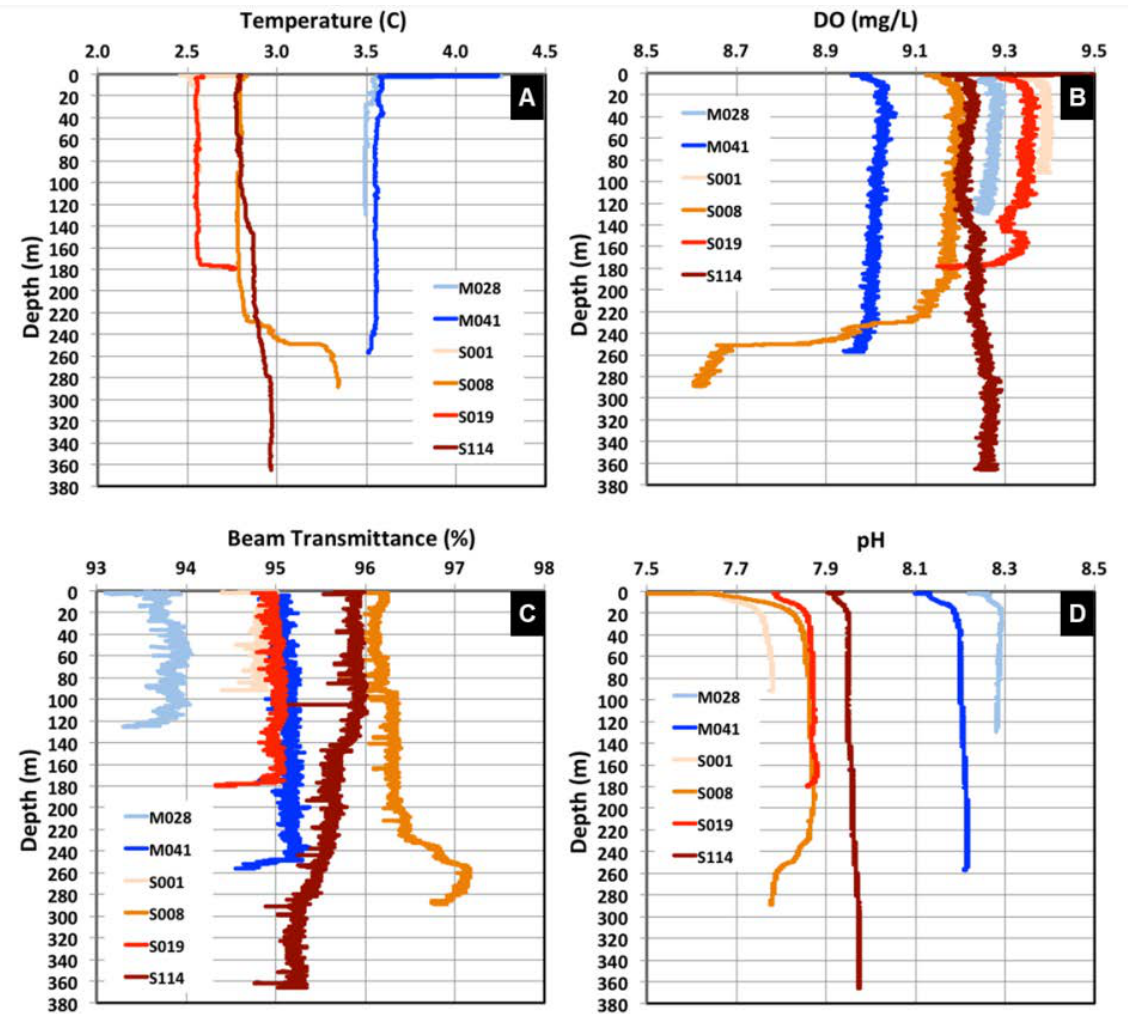
Figure 2. Water column profiles of physical and chemical parameters in Lakes Michigan and Superior. Shown are ( A ) temperature, ( B ) dissolved oxygen (DO), ( C ) beam transmittance, and ( D ) pH as a function of depth.